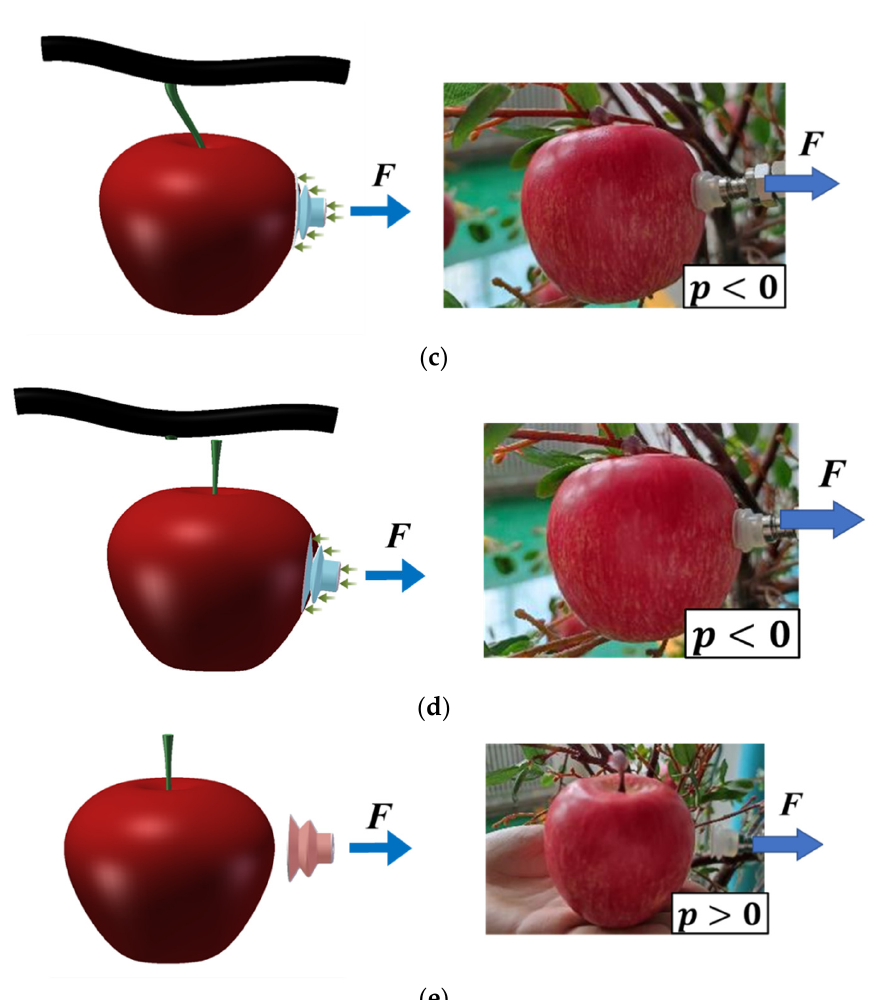
Figure 26. Sucking process of the suction cup on the apple surface. When the picking mechanical hand picks the apple, the suction cups first touch the apple surface completely with a preload force F (as in ( a )). When the negative pressure is generated by the suction cup through the air pump, the negative pressure difference pulls the suction cup toward the apple and pushes the apple with the preload force so that it completely contacts the apple surface (as in ( b )). Before the edge of the inner cavity of the suction cup completely touches the surface of the apple (i.e., before it is sealed), the difference between the inner and outer pressure is 0. When the picking mechanical hand retracts, the inner surface of the suction cup pulls the apple with the suction force generated by the negative pressure and the picking force F (as in ( c )). At the same time, the static friction between the inner wall of the suction cup and the apple causes the fruit handle to break, thus, achieving the purpose of apple picking (as in ( d )). When the apples are released, the air pump is turned off and the pressure difference between the inner surface of the sucker and its crater and the apples is 0. The apples fall off naturally (as in ( e )).